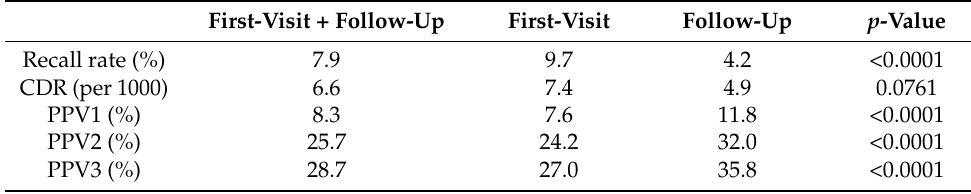
Table 3. Performance of the mammography